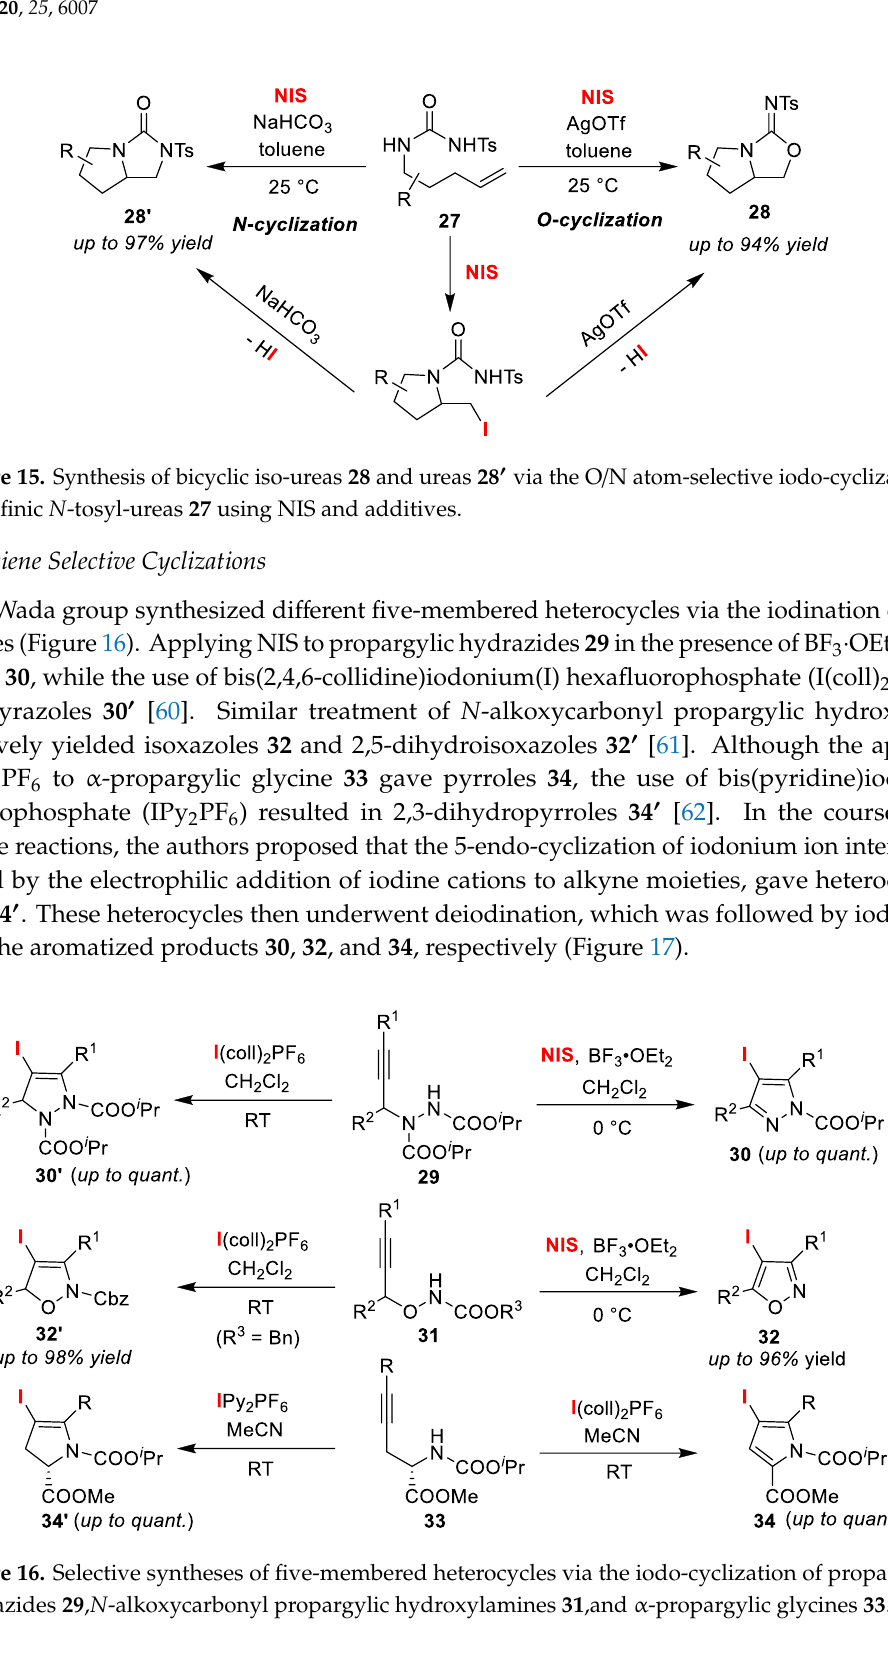
9 of 34 Figure 14. Synthesis of bicyclic iso-ureas 26 and ureas 2 6′ via O / N atom-selective iodo-cyclizations of olefinic N -tosyl-ureas 25 using different active iodine species. Li and Widenhoefer developed the O/N atom-selective cyclizations of olefinic N -tosyl-ureas 27 using NIS [58]. Reaction conditions using AgOTf gave bicyclic isoureas 28 via O -cyclization, whereas